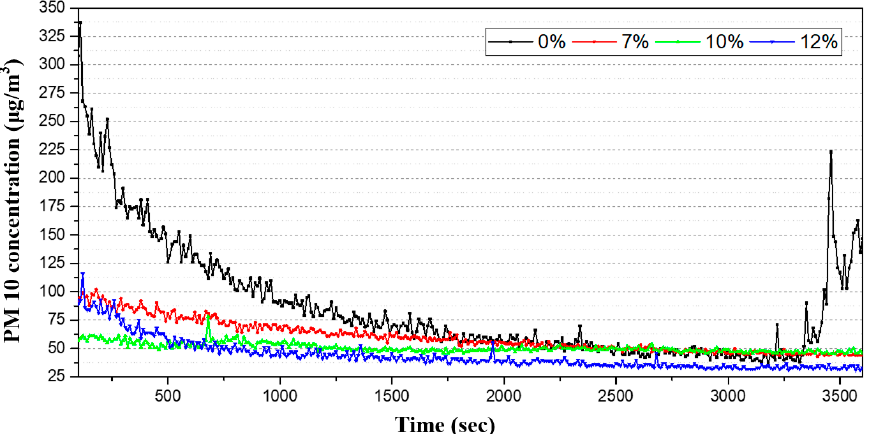
Figure 10. PM 10 dust generation for soil samples.